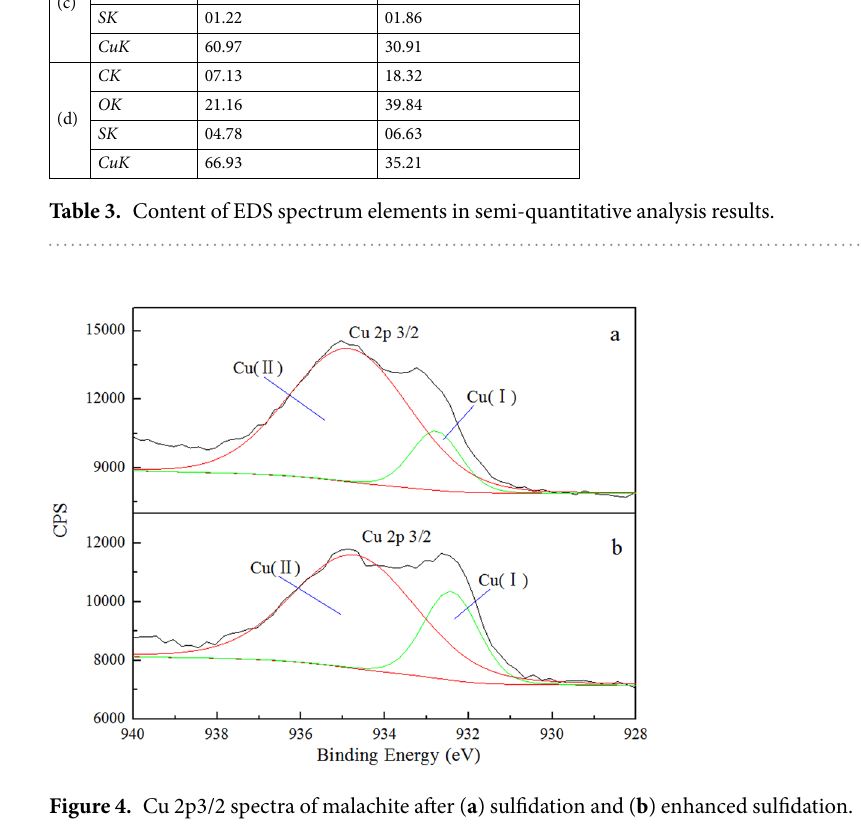
Figure 4. Cu 2p3/2 spectra of malachite after ( a ) sulfidation and ( b ) enhanced